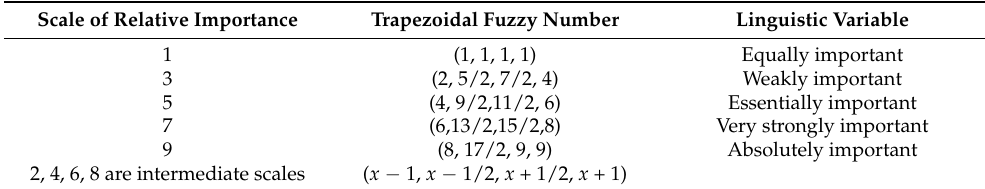
Table 2. The nine-point scale of relative importance used in the pair-wise comparison of AHP. Scale of Relative Importance